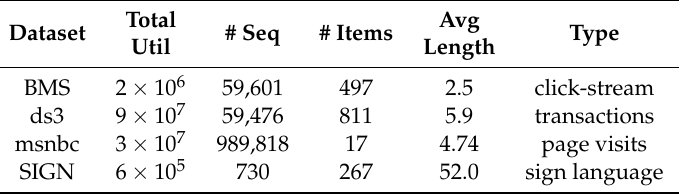
Table 1. Datasets used in